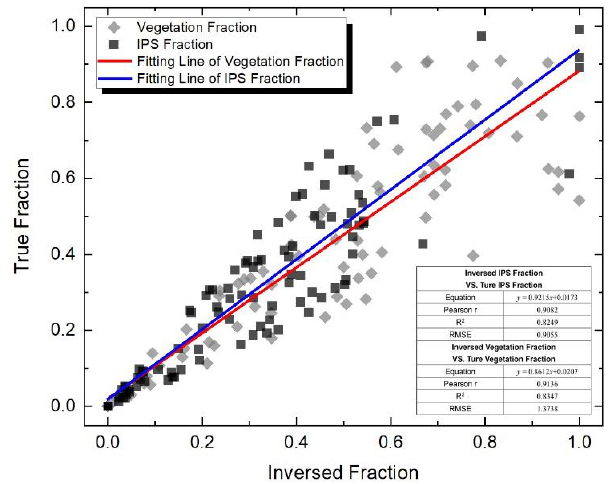
Figure 5. Inversion images of impervious surface density (ISPD) (left ( a – c )) and land surface tem- perature (LST) (right ( d – f )).